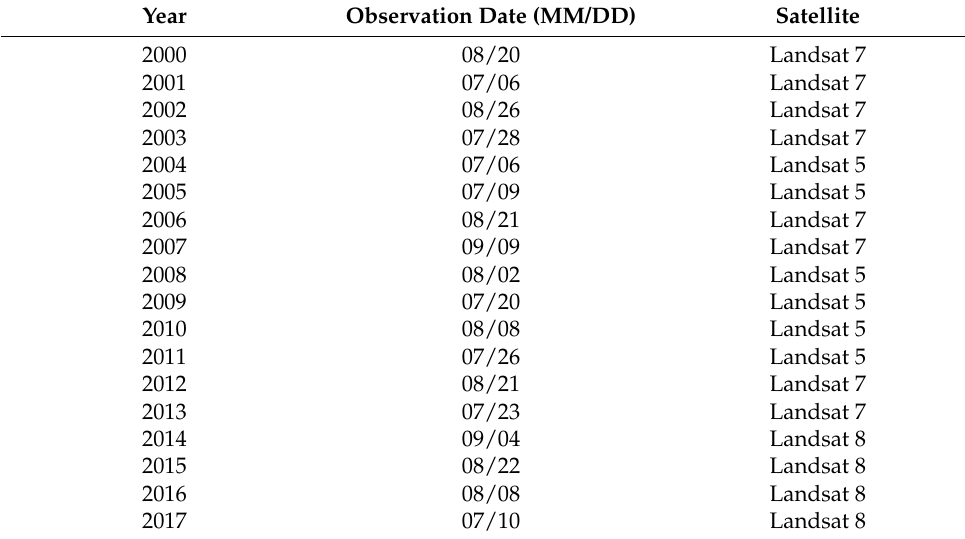
Table 1. Observation dates and sensor platform of Landsat data.